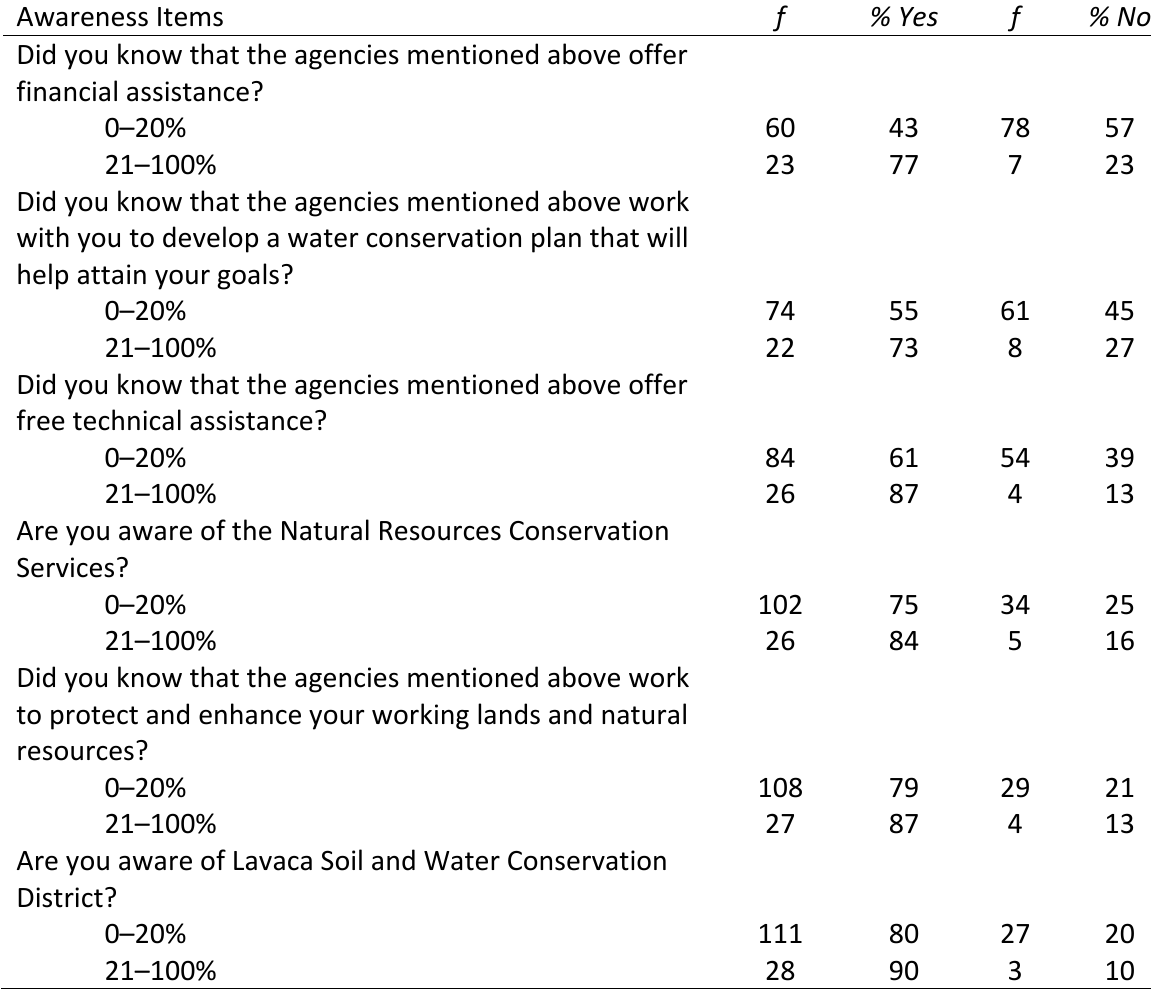
Descriptive Statistics of Agricultural Income on Awareness of Natural Resources Conservation Services & Texas State Soil and Water Conservation